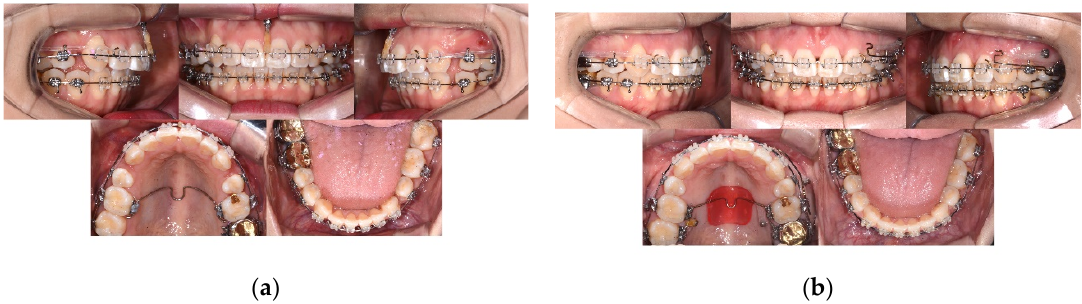
Figure 4. Treatment progress: ( a ) a single TSAD installed beneath the ANS and two buccal TSADs between the molars were used for the retraction and intrusion of anterior teeth. ( b ) Intrusion force was applied to the maxillary posterior teeth with a combination of TPA and maxillary buccal TSADs. Moreover, the intrusion of the posterior teeth provided the patient with a more esthetic smile line, as her flat maxillary occlusal plane angle was improved. To reduce overjet, her maxillary anterior teeth were retroclined (U1-FH, 100.0 ◦ ). These changes contributed not only to the correction of the anterior open bite but to the improvements in the facial profile (Figure 5; Table